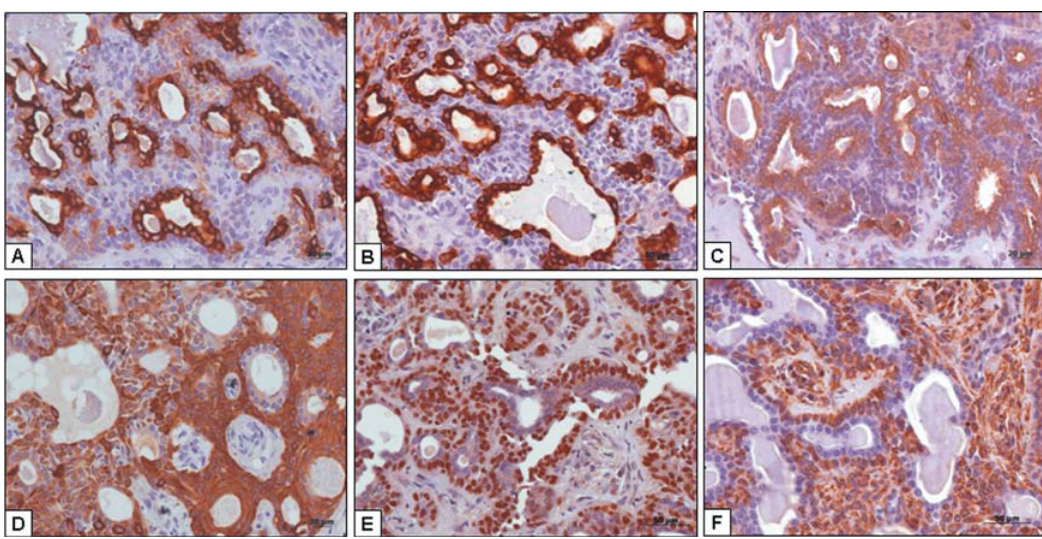
Figure 4- (cid:2)’(cid:16)(cid:16)(cid:9)(cid:4)(cid:15)(cid:7)(cid:19)(cid:15)(cid:29)(cid:10)(cid:12)(cid:2)(cid:15)(cid:17)(cid:2)(cid:13)(cid:9)(cid:5)(cid:11)<(cid:10)(cid:14)(cid:18)(cid:12)(cid:2)(cid:8)(cid:11)(cid:19)(cid:9)(cid:5)(cid:11)(cid:9)(cid:19)(cid:12)(cid:8)(cid:27)(cid:2)=(cid:9)(cid:16)(cid:14)(cid:4)(cid:6)(cid:10)(cid:2)(cid:5)(cid:12)(cid:10)(cid:10)(cid:8)(cid:2)(cid:14)(cid:4)(cid:11)(cid:12)(cid:4)(cid:8)(cid:12)(cid:10)(cid:20)(cid:2)(cid:7)(cid:15)(cid:8)(cid:14)(cid:11)(cid:14)(cid:21)(cid:12)(cid:2)(cid:17)(cid:15)(cid:19)(cid:2)(cid:5)(cid:20)(cid:11)(cid:15)(cid:18)(cid:12)(cid:19)(cid:6)(cid:11)(cid:14)(cid:4)(cid:2)(cid:24)(cid:28)>(cid:26)(cid:2)?(cid:2)(cid:24)(cid:25)(cid:26)(cid:2)(cid:6)(cid:4)(cid:13)(cid:2)(cid:28)>$Q(cid:2)(cid:24)X(cid:26)(cid:2) and moderately positive for CK8 (C). Abluminal cells moderately positive for high-molecular-weight (CKs) (D), p63 (E) and vimentin (F). Immunoperoxidase